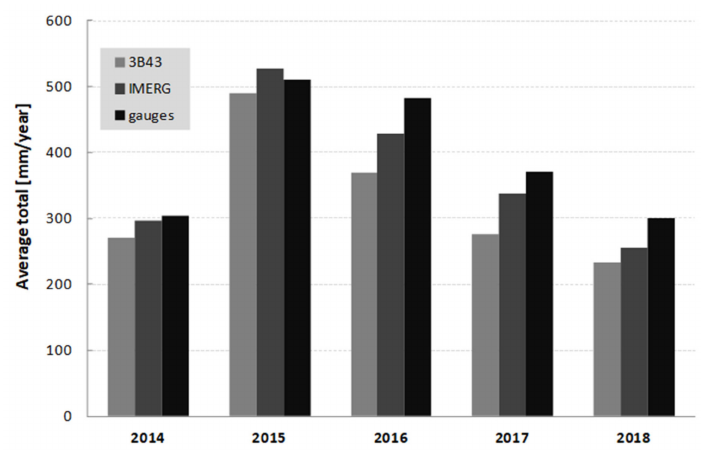
Figure 6. Mean annual values of gauge stations and Satellite Precipitation (SP) data.